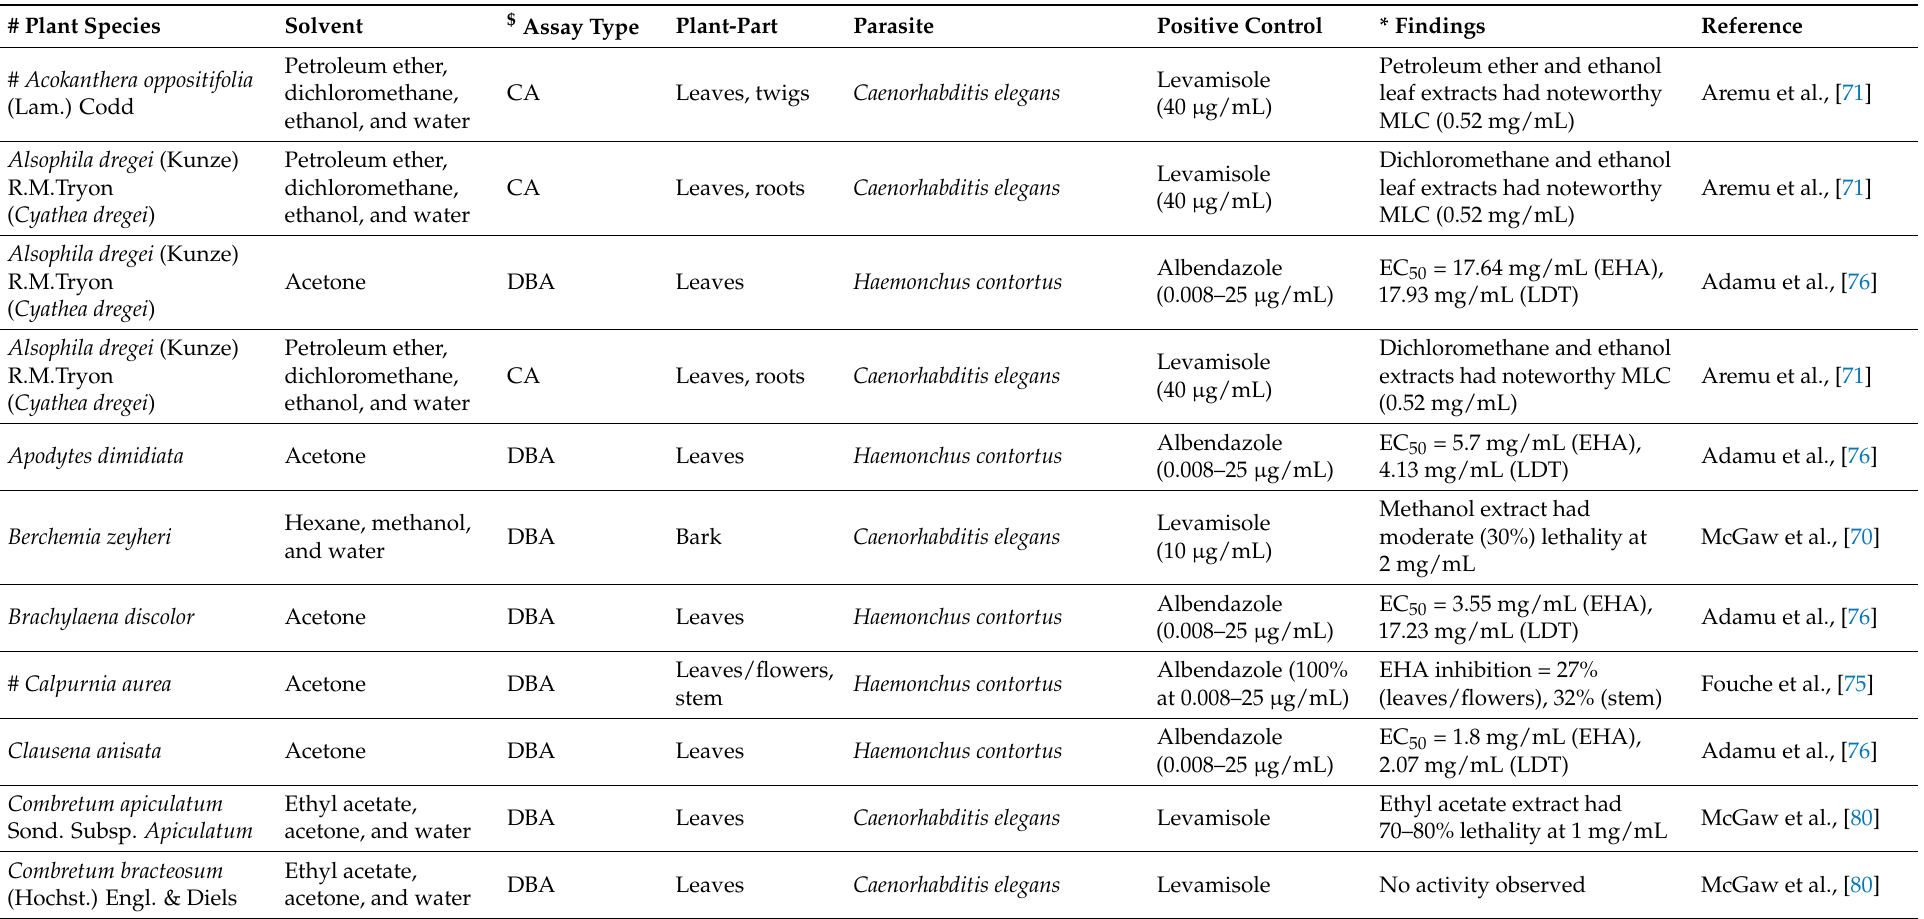
Table 4. Examples of anthelmintic effects of woody plants with ethnoveterinary applications in South Africa. # Plant species: denotes woody plants with ethnoveterinary uses in Table 2; $ Assay type: CA—colourimetric assay, DBA—developmental and behavioral assay; * Findings: EHA—egg hatch assay; LDT—larval development test; MLC—minimum lethal